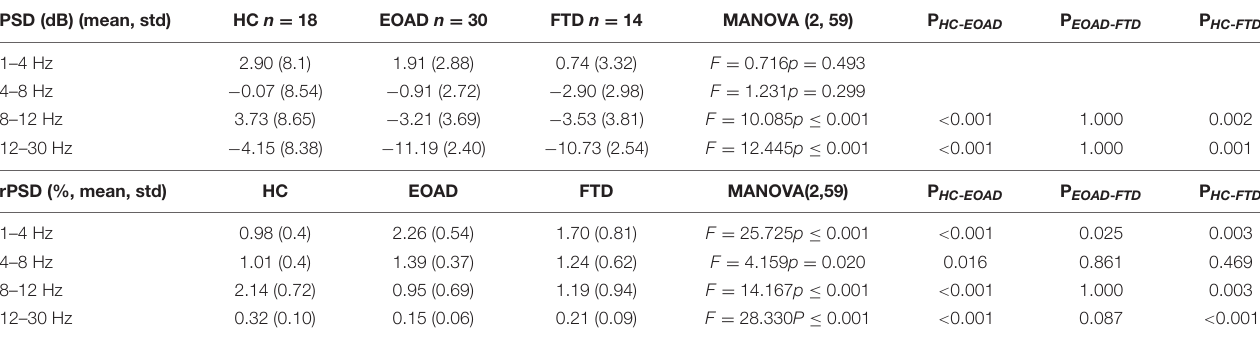
FIGURE 4 | Frequency spectral analysis. (A) and (C) Across-channel grand average of absolute power spectral density (PSD, dB) and relative PSD (% µ V 2 Hz − 1 ) over frequency for each group are illustrated. (B) and (D) The topographies were calculated from PSD in each frequency band. A general slowing EEG was presented in both FTD and EOAD groups. FTD, frontotemporal dementia; EOAD, early-onset Alzheimer’s disease; HC, healthy controls. TABLE 5 | Power spectral density in dementia and control